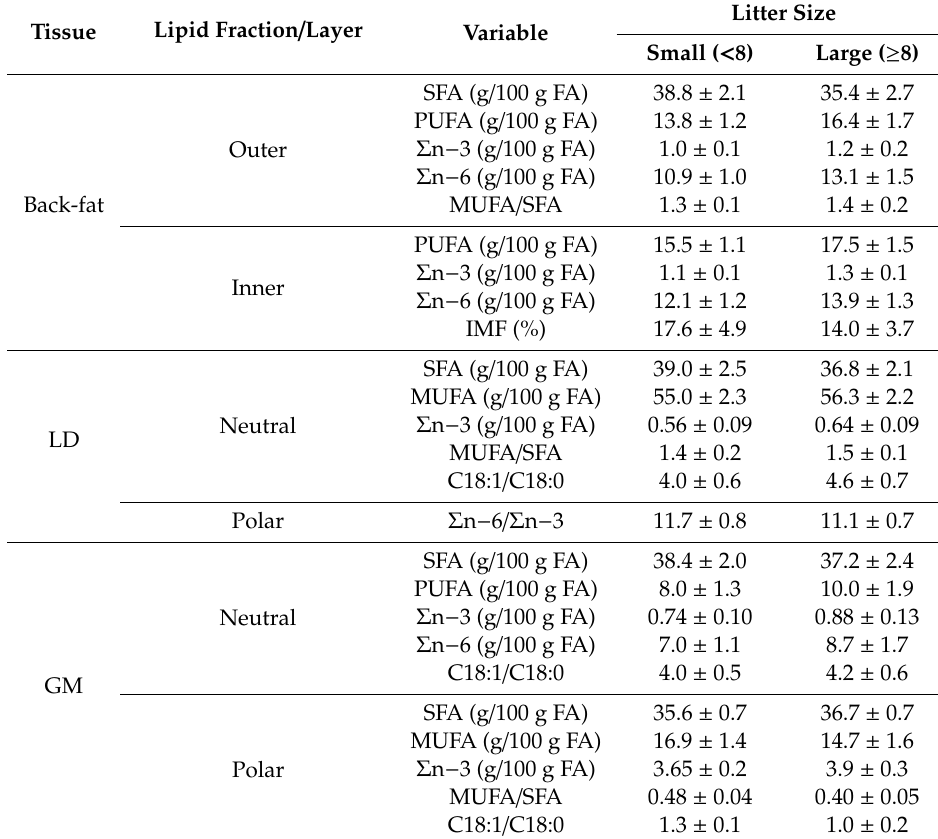
Table 6. Highlighted significant di ff erences ( p < 0.05) in fatty acid composition of back-fat and muscle between piglets from small and large litters at 180 days old.